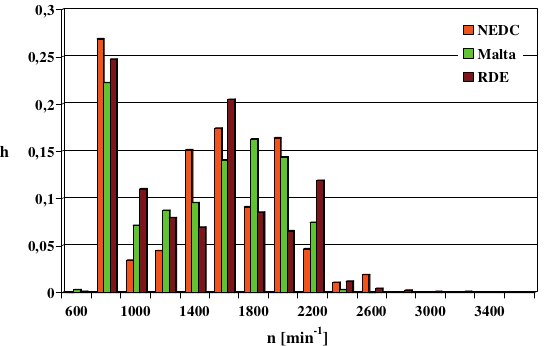
Fig. 18. Engine speed histogram in NEDC, Malta and RDE tests